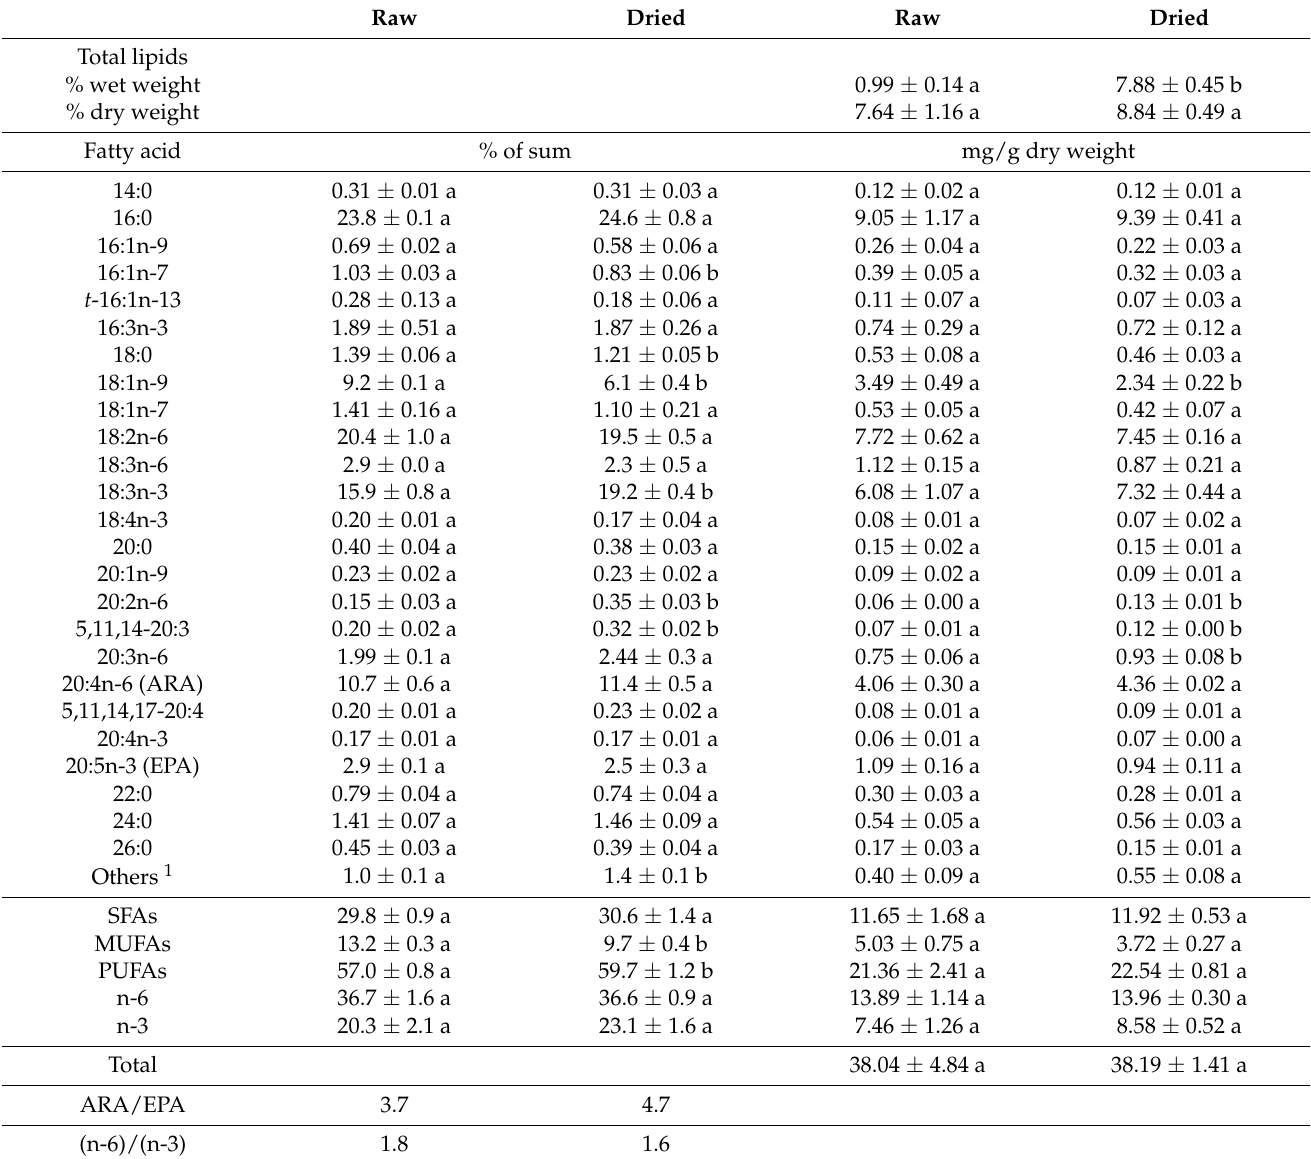
Table 3. Lipid and fatty acid content of raw and processed fiddleheads of the ostrich fern ( Matteuccia struthiopteris ). Raw Dried Raw Dried Total lipids % wet